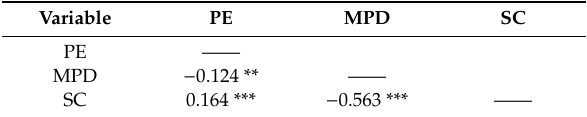
Table 2. Spearman’s or Pearson’s correlation coe ffi cients of PE, MPD, and SC. Variable PE MPD SC PE —— MPD − 0.124 ** —— SC